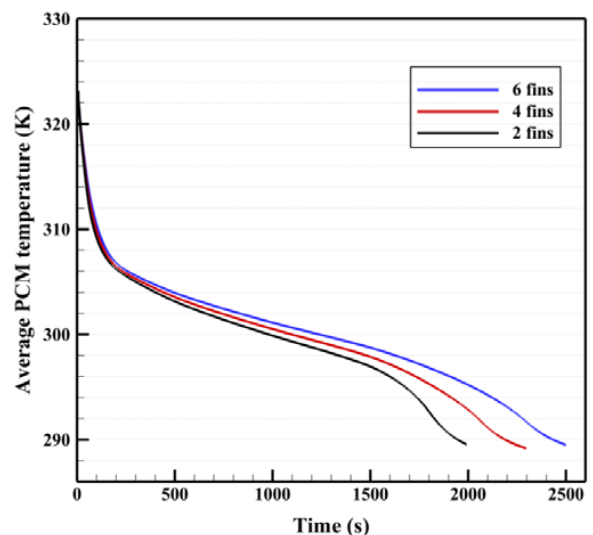
Figure 7. Time history of average temperature for the three different cases of twisted